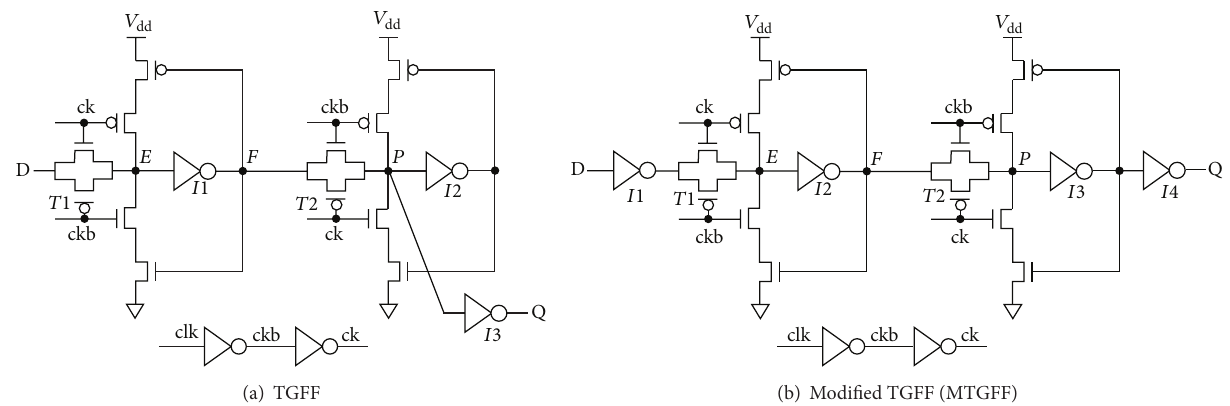
Figure 2: Transmission gate flip-flops (TGFFs) [2,